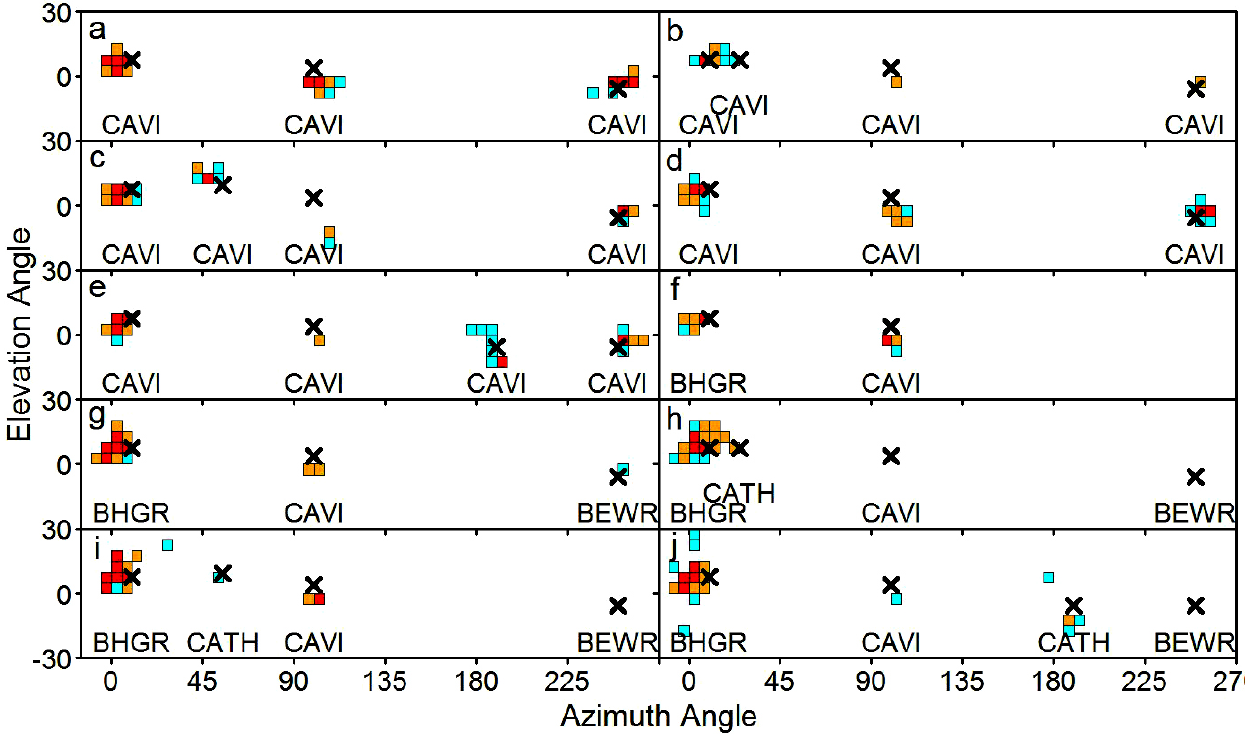
Fig. 4 . Visual representation of the results of experiments testing the ability of the microphone system to determine the direction-of- arrival (DOA), in both the azimuth and elevation directions, to multiple sources being broadcast at the same time from varying directions. The number of sources was either two (f), three (a, d, and g), or four (b, c, e, h, i, and j). All sounds were broadcast from speakers placed 15 m from the microphones. Xs denote the DOA of each source, as measured in the field, and the species name is indicated beneath each X. Colored rectangles indicate the number of sounds estimated to have originated from each direction (blue: 1 sound; orange: 2–5 sounds; red: > 5 sounds). DOA estimates for 852 sounds are shown. Though DOA was estimated with a resolution of 1°, rectangles are shown with a resolution of 5° for